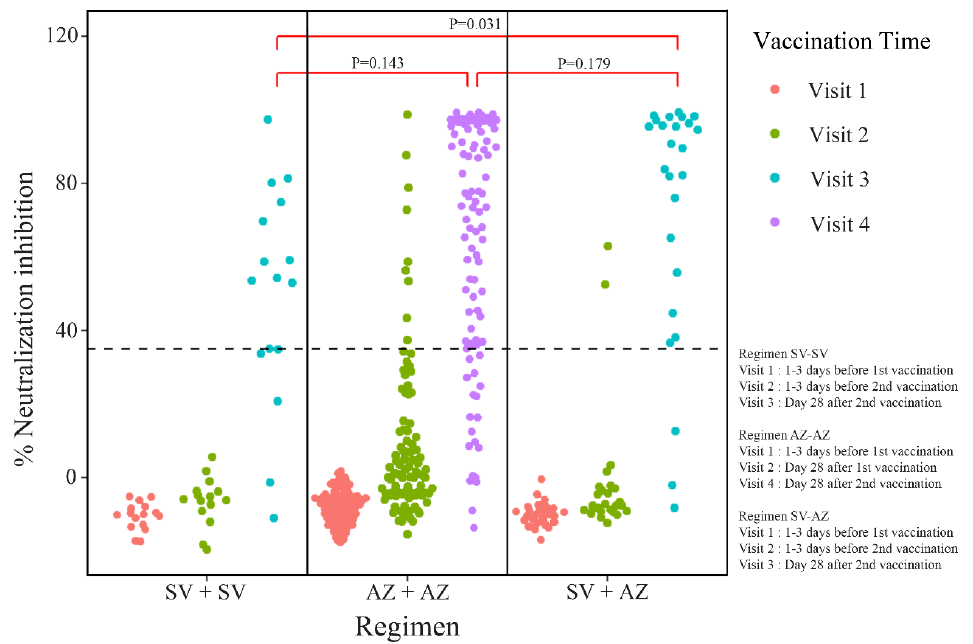
Figure 3. Percentage of SARS-CoV-2 surrogate virus neutralization test results at different visits of each vaccine regimen. AZ-AZ, homologous AZD1222 regimen; SV-AZ, heterologous Sinovac- AZD1222 regimen; SV-SV, homologous Sinovac regimen.